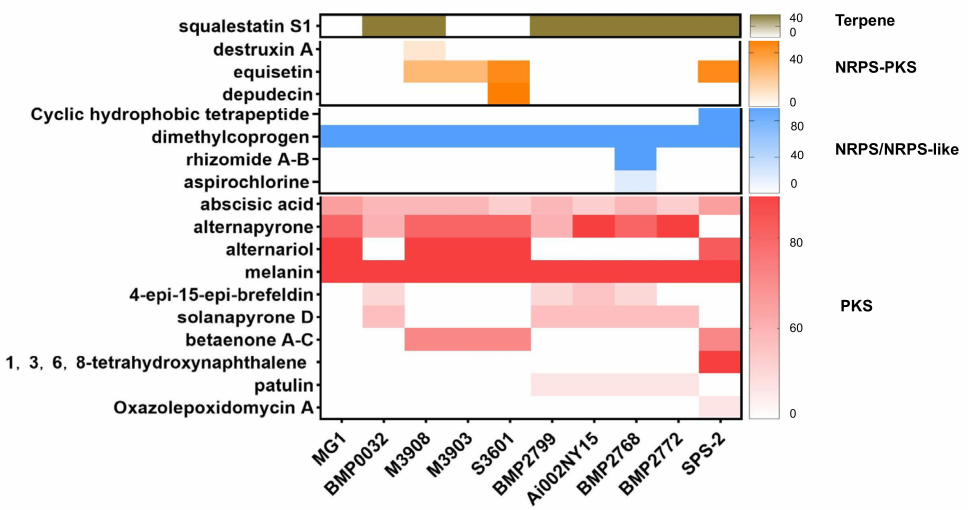
Figure 6. Putative secondary metabolites produced by strain SPS-2 and other Alternaria strains deposited in the antiSMASH database.